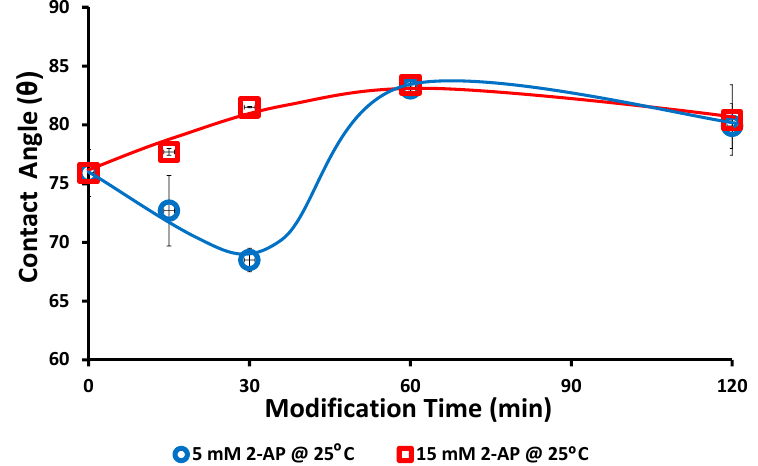
Figure 5. Change of the static water contact angle with the reaction (modification) time. Common reaction condition is pH 5.5 (0.1 M sodium acetate buffer), and 0.5 U·mL − 1 enzyme (laccase). Two modifier concentrations, 5 mM (blue) and 15 mM (red) (2-aminophenol), were used at 25 °C reaction temperature and 15, 30, 60, and 120 min reaction times. The solid lines are guides for general trend for the studied conditions.